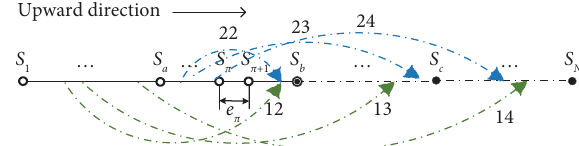
trains in section 1